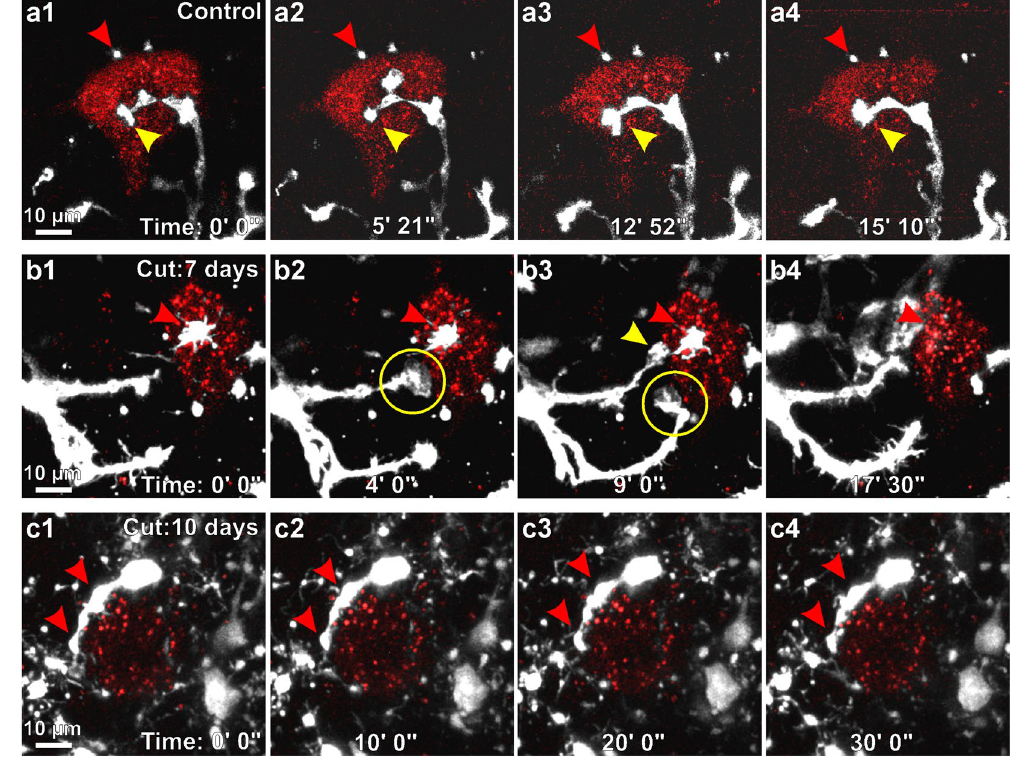
Figure 5. Microglia interactions with control and axotomized motoneurons. ( a1–4 ) CX3CR1-GFP microglia (white) scanning the surface of LG motoneurons retrogradely labeled with CTB-555 (red) in a sham control animal (corresponds to Supplementary movie 6). Microglia send dynamic processes (yellow arrowhead) towards the motoneuron cell surface. Additionally, there are a few small microglia processes that make direct contact with the motoneuron and are stationary (red arrowhead). ( b1–4 ) Microglia interactions with axotomized motoneurons 7 days post-injury (corresponds to Supplementary movie 7). At this time point, microglia extend their processes specifically towards the surface of the motoneuron (yellow arrowhead, ( b3 ) at which point they form phagocytic cups close to the motoneuron surface (yellow circles). When the phagocytic cup disappears, the process is retracted. In addition, there are stationary microglia processes (red arrowhead) extending filopodia constantly scanning the motoneuron surface. ( c1–4 ) Microglia covering the motoneuron surface 10 days after axotomy (corresponds with Supplementary movie 9). Microglia in this position are stationary and their cell bodies and processes (red arrowheads) are attached to the motoneuron surface. Filopodia lining microglia processes are active and in constant